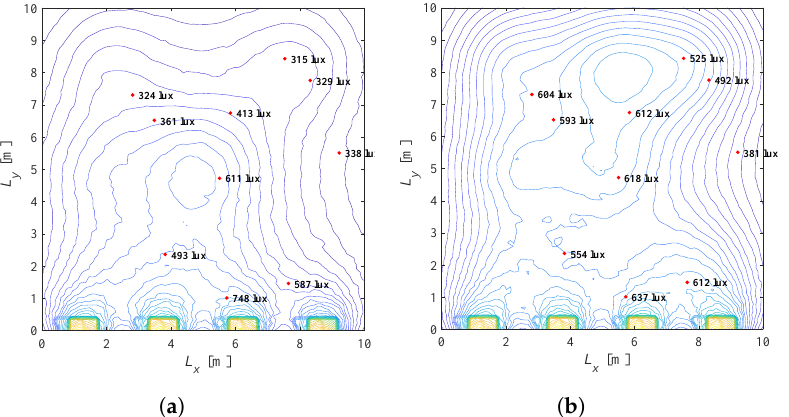
Figure 20. Solution of the Problem 6 defined in (24). ( a ) λ = 0.01, a = 0.2, G = 0.2; ( b ) λ = 0.5, a = 0.16, G =